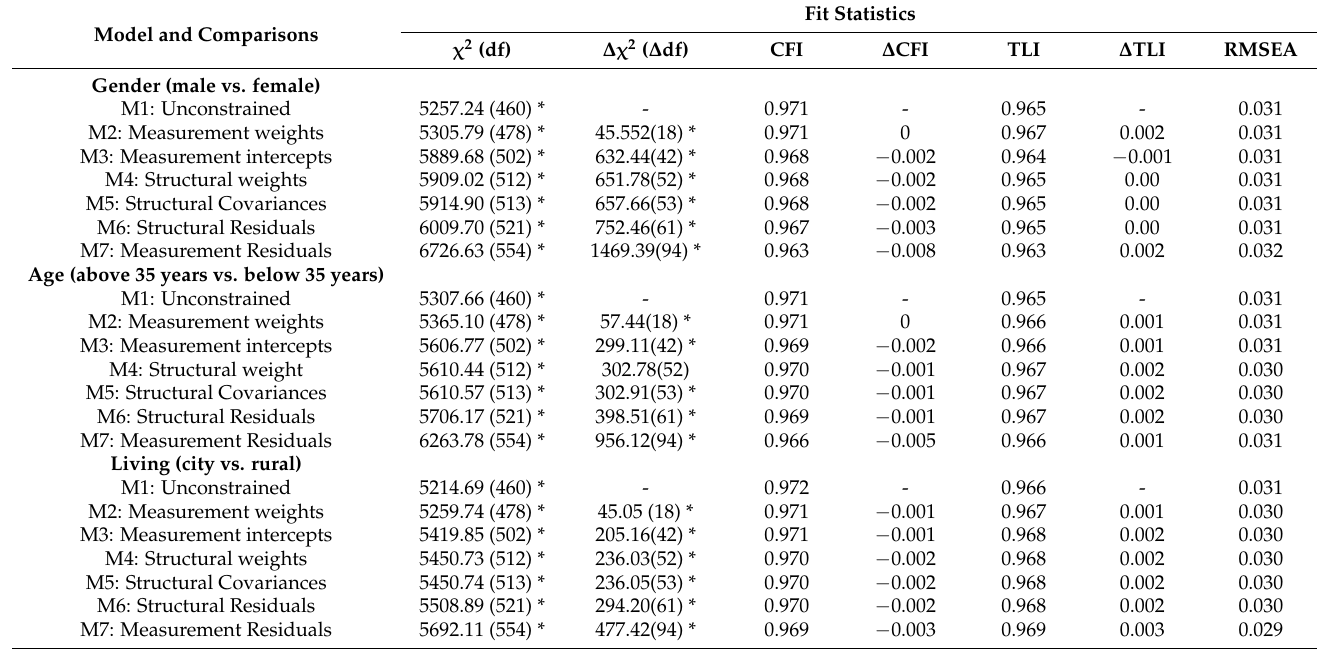
Table 4. Invariance evaluation across age, gender, and living place through multigroup structural equation modeling. Model and